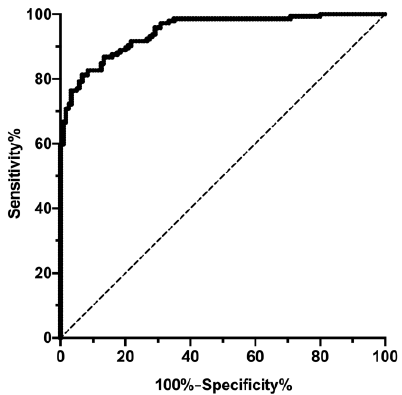
Figure 5. Receiving operator characteristic (ROC) curves of gender, age, number of fasting days, and baseline parameters (GOT, GPT, total cholesterol, diabetes status, and FLI) for the prediction of FLI ≤ 60 after fasting intervention.